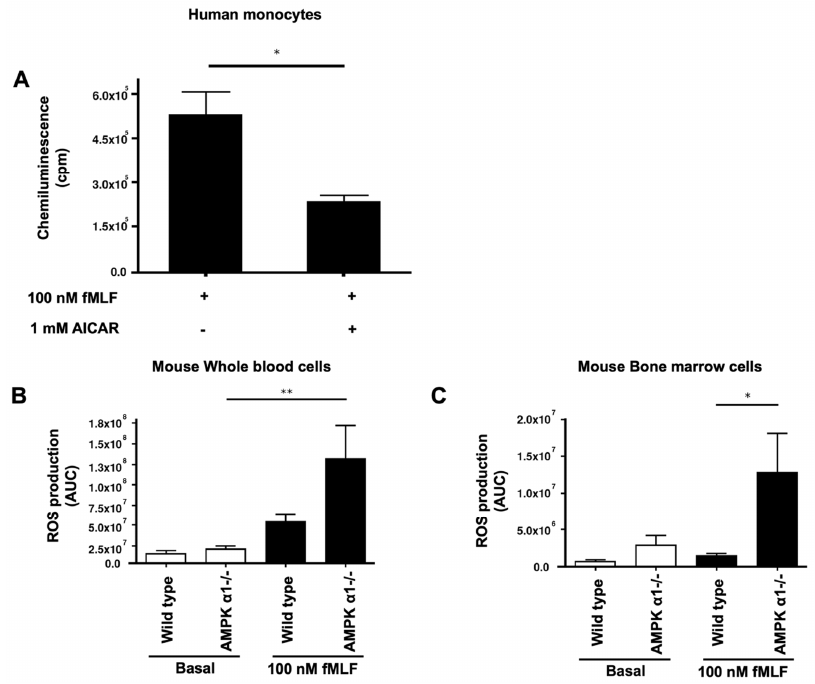
Figure 7. Effect of AMPK activation in human isolated monocytes and AMPK depletion in murine whole blood and bone marrow cells on ROS production. Human monocytes were incubated in the absence or the presence of AICAR (1 mM), stimulated by fMLF (100 nM), and ROS production was measured by luminol-amplified chemiluminescence ( A ). ROS production of whole blood cells ( B ) and bone marrow cells ( C ) isolated from of wild-type mice and AMPK α 1-/- mice increased in the presence of fMLF (100 nM). A stronger response to fMLF was observed with AMPK α 1-/- versus wild-type cells. The induced luminol-amplified chemiluminescence was measured using the lumi- nometer for 15 min. Data are mean of chemiluminescence (n = 3). * p value < 0.05 and ** p value < 0.01.